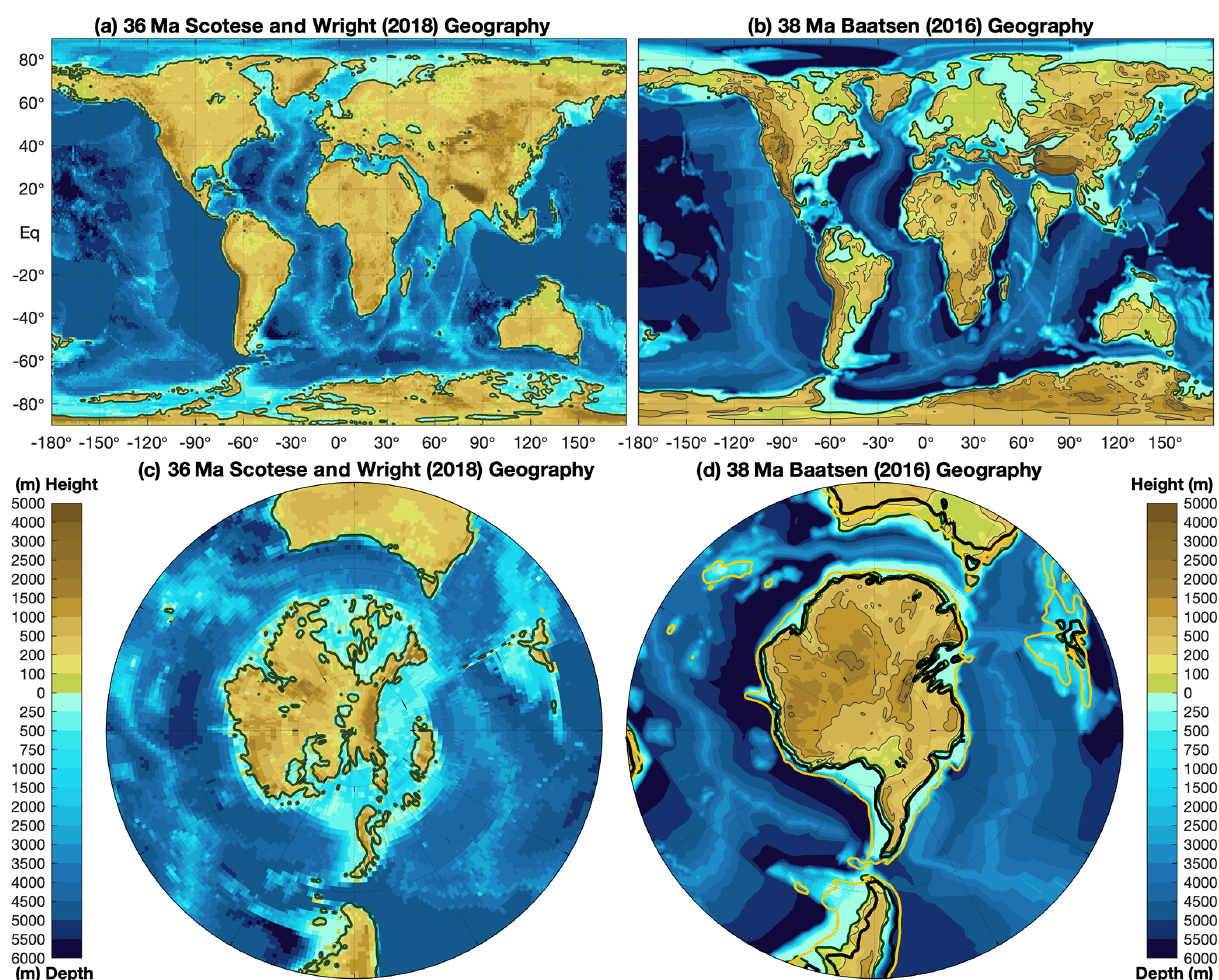
Figure 2. Palaeogeography in the late Eocene showing two alternative reconstructions. Panels (a) and (c) use the hot spot reference frame, using the Scotese and Wright (2018) palaeogeography at 36Ma, while panels (b) and (d) use the palaeomagnetic reference frame showing the reconstruction of Baatsen et al. (2016) at 38Ma. These two reconstructions use different methodologies and are presented as broadly indicative of the uncertainties in palaeogeography at this time. Also shown in panel (d) are post-EOT coastlines at 30Ma (black contours) and 1000m depth (orange contours), which illustrate the widening of the Southern Ocean gateways during the 8Myr interval around the